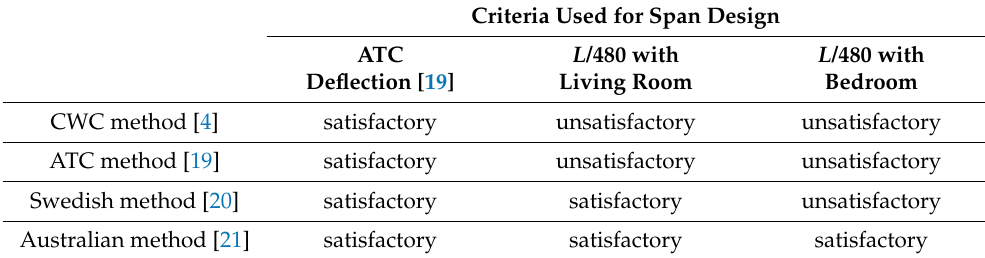
Table 5. Vibration assessment of laboratory floors with span lengths designed based on the ATC method [19] and the deflection limit of L /480, according to various design methods considered in Xu [36]. Data reproduced from Xu [36] with